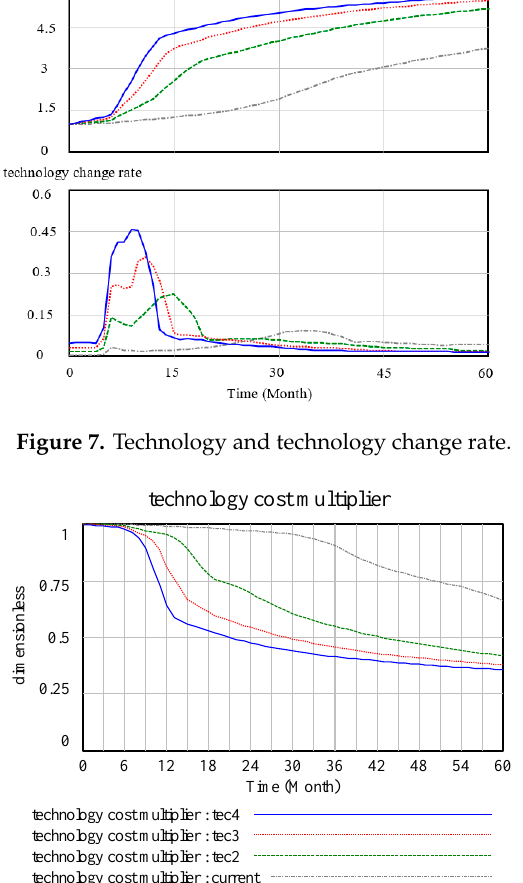
Figure 8. Technology cost multiplier.